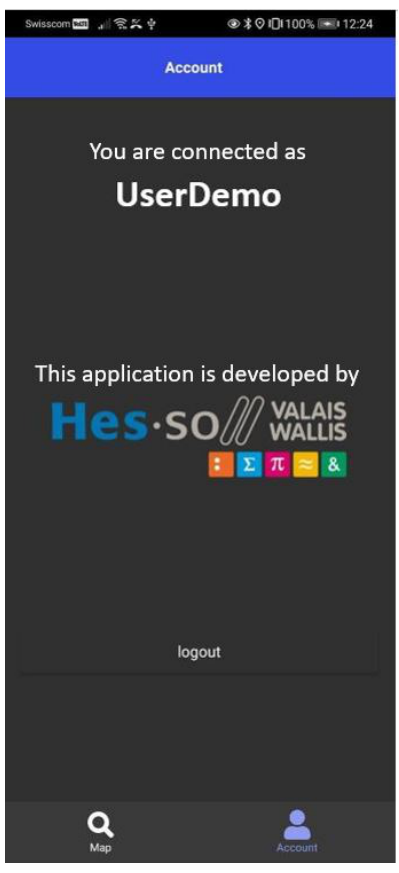
Figure 11. Account